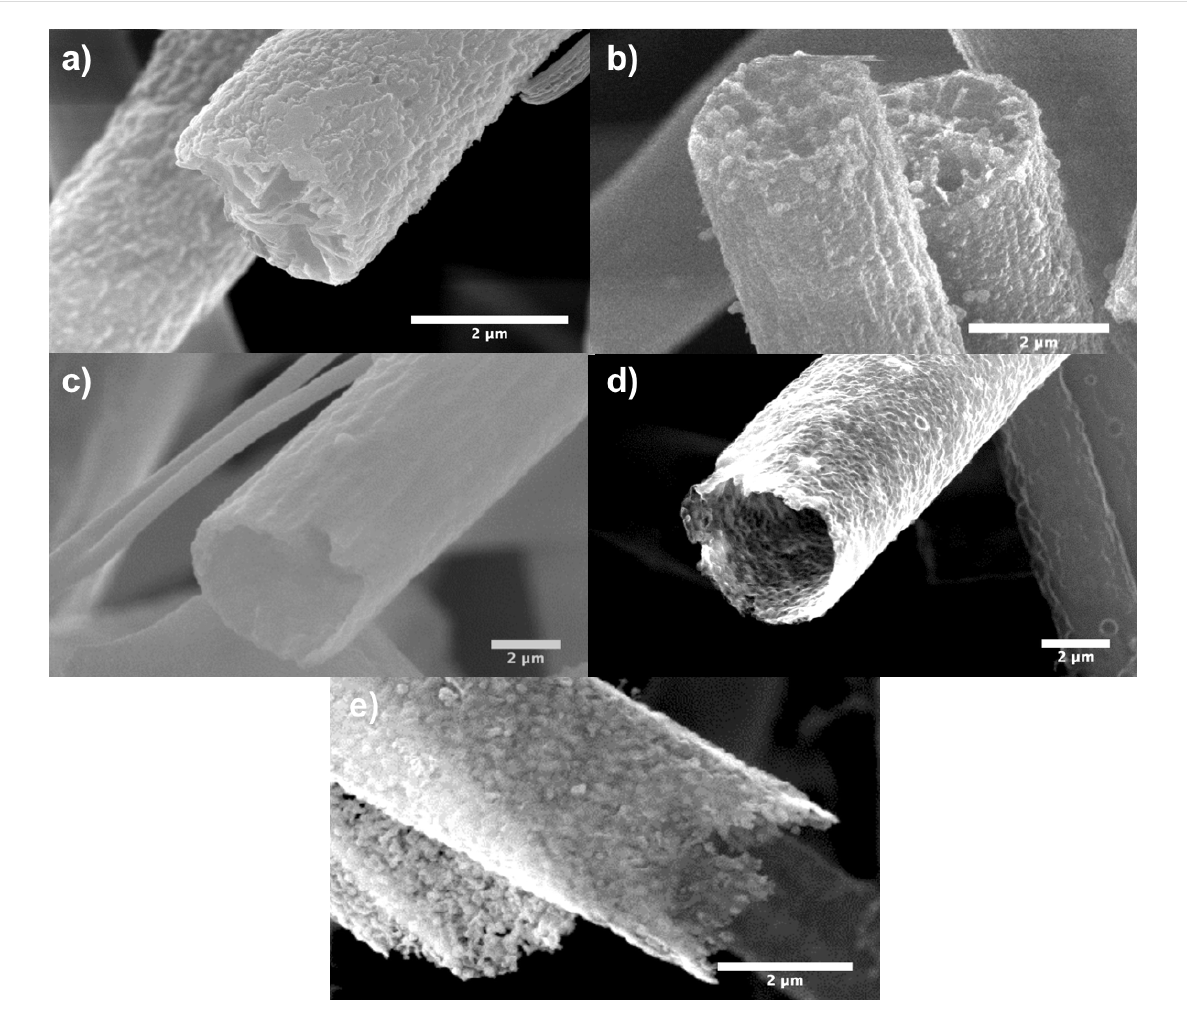
Figure 2: SEM images of (a) polystyrene fibres ( 1 ), (b) silica@polystyrene composite fibres ( 2 ), (c) silica@carbon composite fibres ( 3 ), (d) carbon tubes ( 4 ) and (e) silicon carbide tubes ( 5 ).